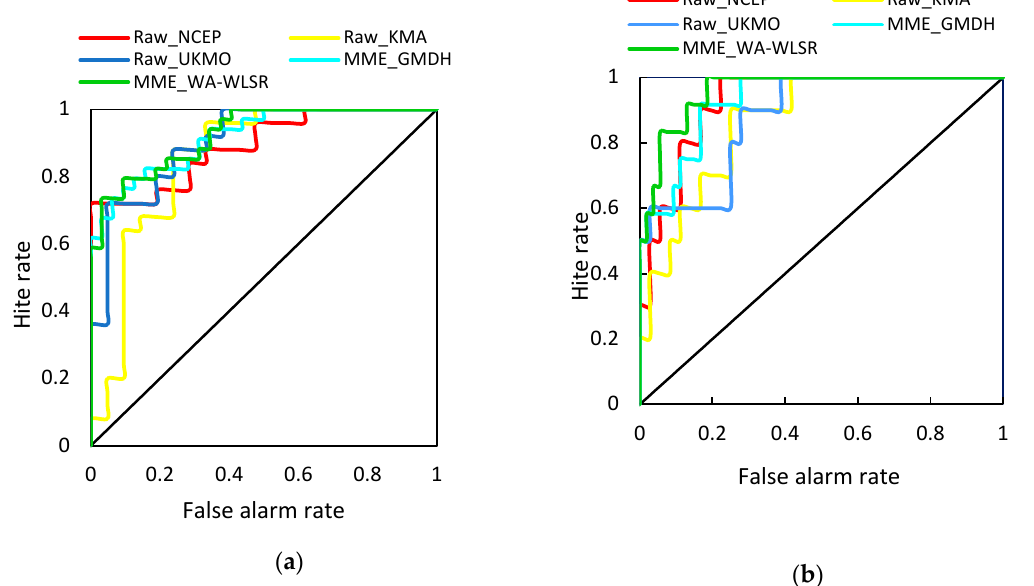
Figure 6. ROC diagrams for raw and post-processed ensemble precipitation forecasts: ( a ) 2.5 mm ( b ) 10 mm.